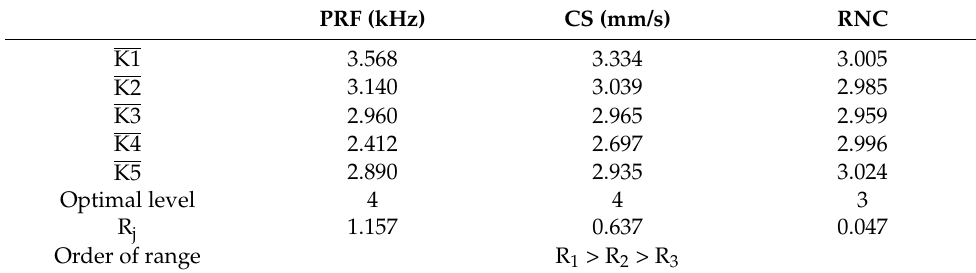
Figure 5. ( a ) Effect of process parameters on diameter of the micro-hole. ( b ) Interactions between each parameter for diameter of the micro-hole. Table 7. Range analysis table based on size of the HAZ.